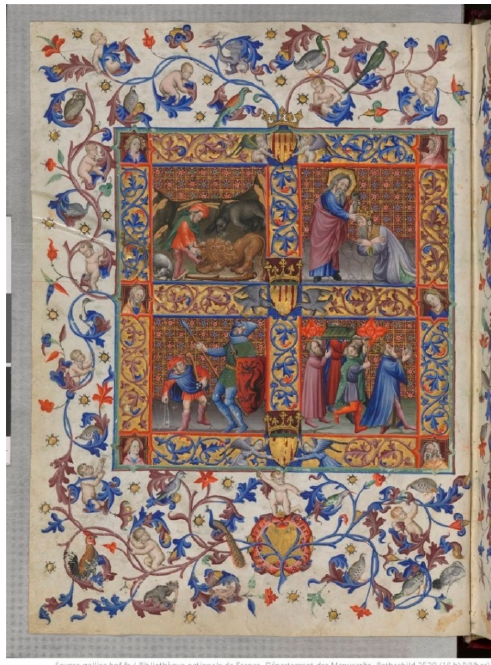
Figure 4. David stories in the Breviarium secundum ordinem Cisterciencium , also known as Breviary of king Martin of Aragon. Paris, Bibliothèque nationale de France, ms. Rothschild 2529, f. 17v. Used by permission.